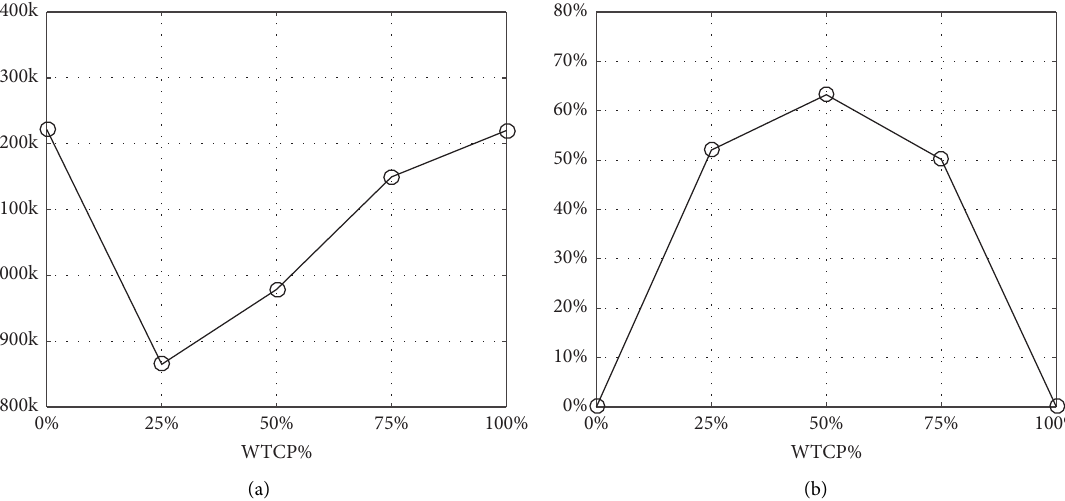
Figure 11: Total cost (a) and proportion of packages transported by taxi on spoke links (b) with different WTCP% (dependent on payment for incentive).